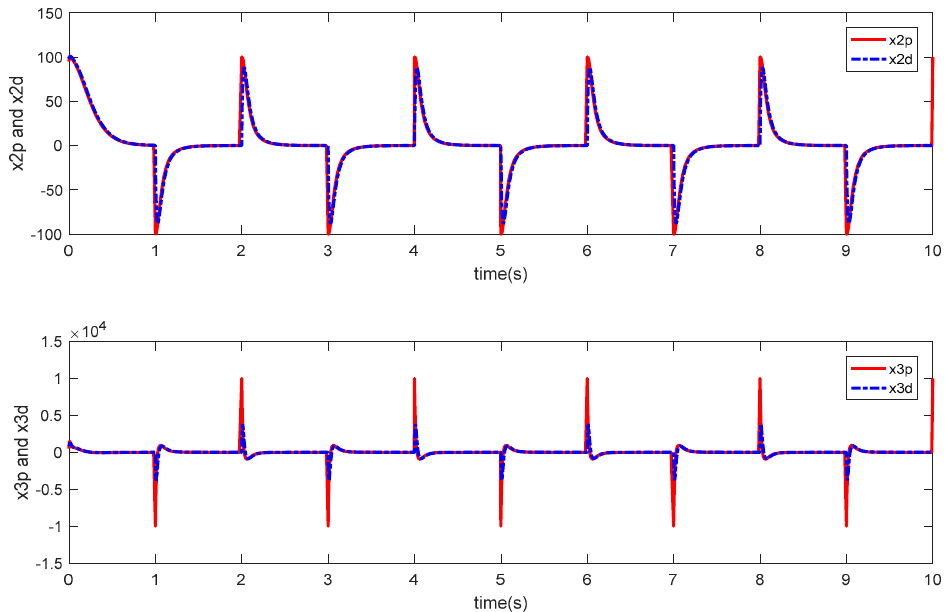
Figure 11. Time response of the first-order low-pass filter. ×2p and ×3p represent the input of the first-order low-pass filter x 2 and x 3 , respectively; × 2d and × 3d represent the output of the first-order low-pass filter x 2 d and x 3 d , respectively.